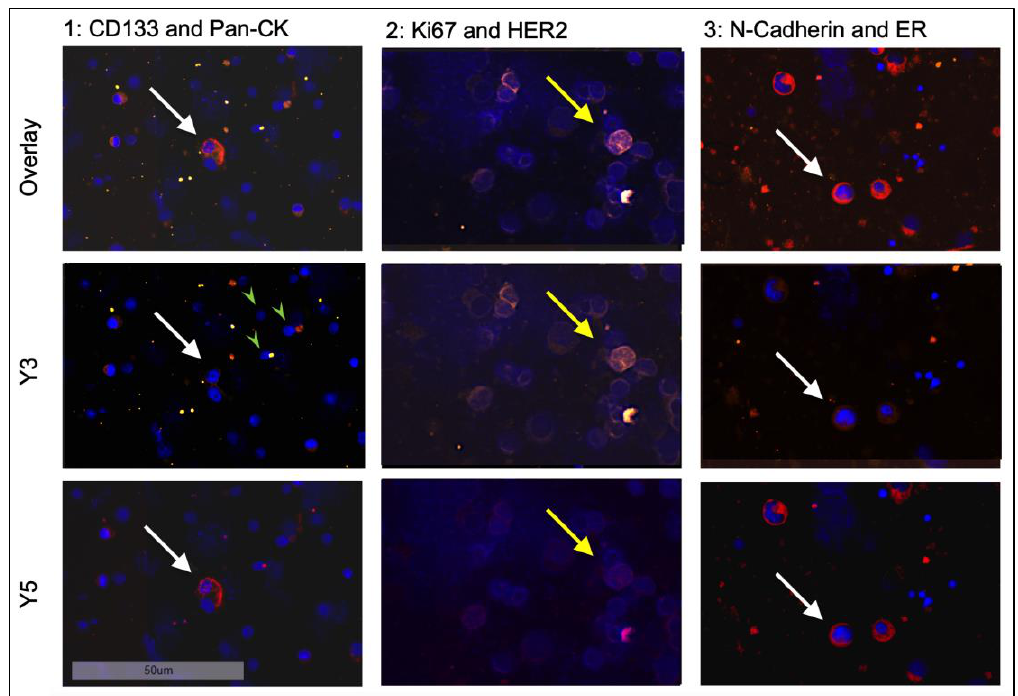
Figure 3. Sequential staining of positive control cell lines ZR75-1 (white arrows) and T98G (yellow arrows) at 20-fold magnification. Shown are three different tumor cells for each staining round. For comparison, hematopoietic bone marrow cells, which are distinctly smaller and only stain positive for DAPI, are marked with green arrowheads.